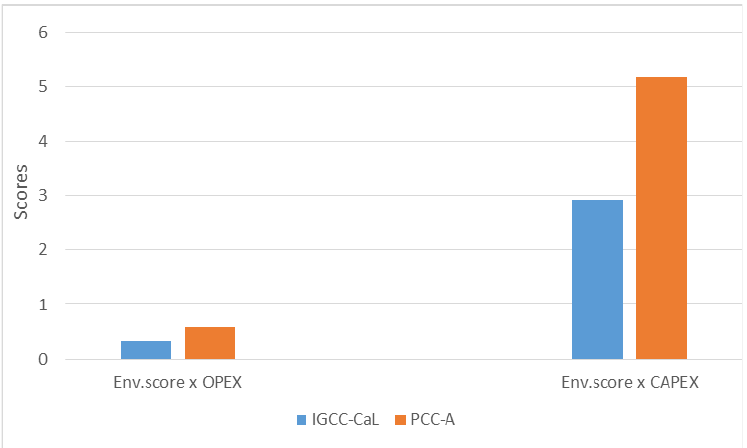
Figure 6. Product of environmental score by CAPEX and OPEX for pre-combustion CO 2 capture integrated into the gasification combined cycle (IGCC-CaL) and post-combustion capture by adsorption of CO 2 by activated carbon (PCC-A).